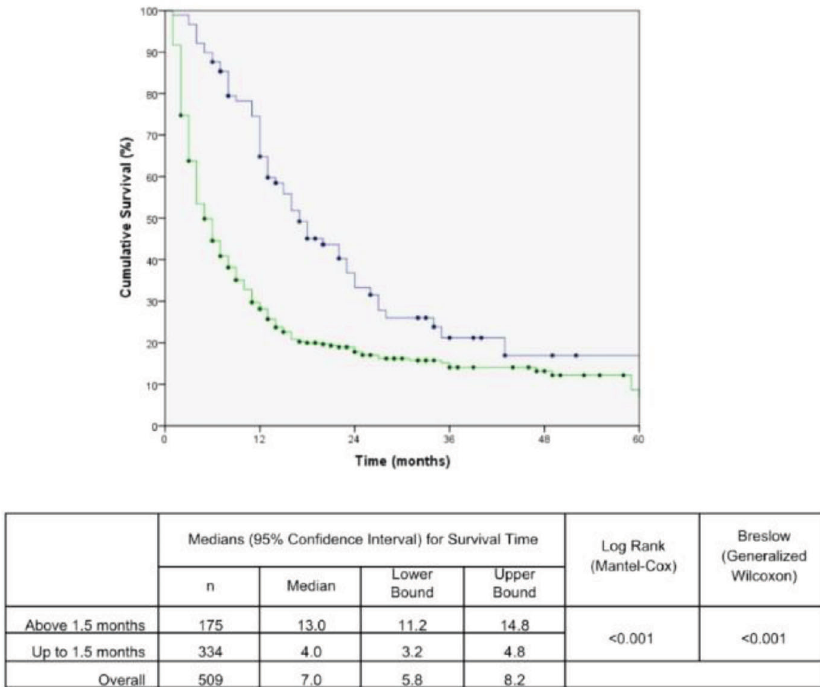
Figure 3 - Kaplan Meier curve for mortality due to lung cancer in patients according to time from diagnosis (DX) to the starting date of treatment (TTO). The blue line represents the patients that started treatment above 1.5 months and green line up to 1.5 months.